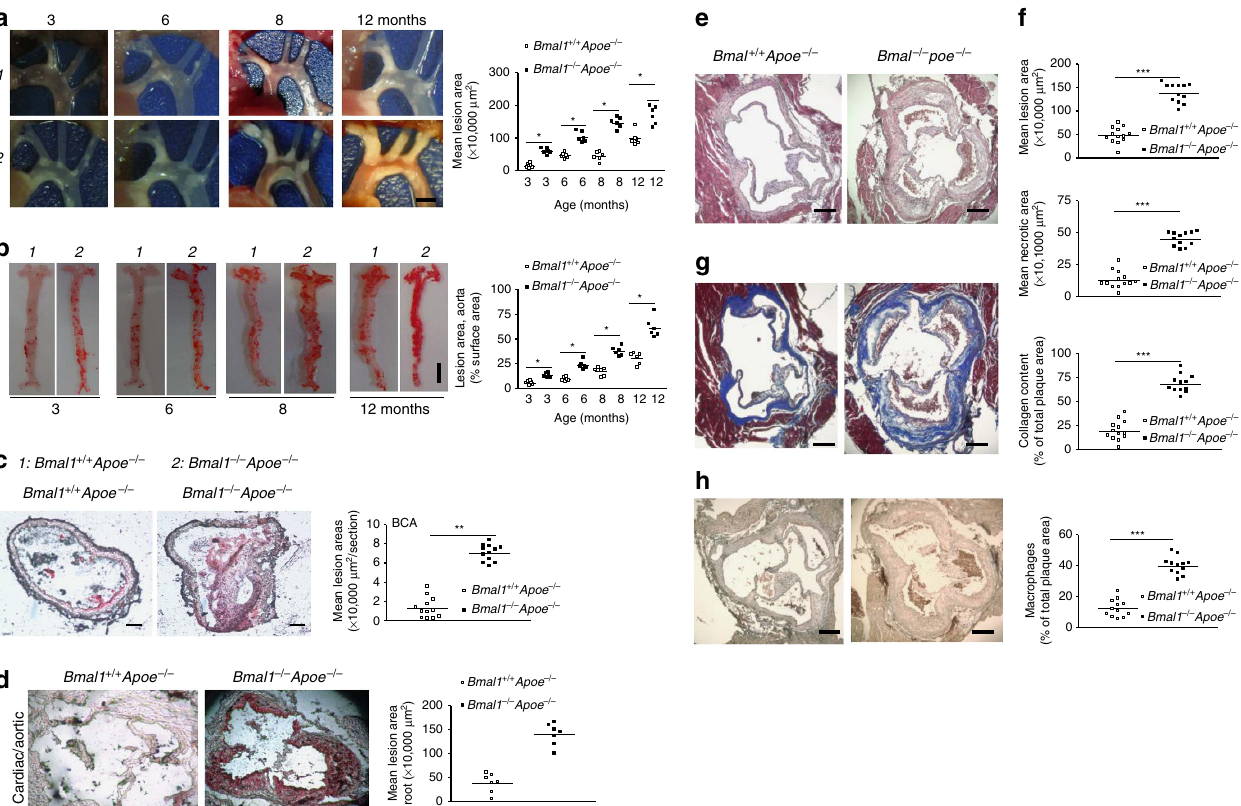
Figure 1 | Bmal1 deficiency enhances atherosclerosis in Apoe (cid:2) / (cid:2) mice. Bmal1 (cid:2) / (cid:2) Apoe (cid:2) / (cid:2) (black square) and Bmal1 þ / þ Apoe (cid:2) / (cid:2) (white square) male mice were fed a chow diet ( n ¼ 6 for each age group) for 3, 6, 8 or 12 months. ( a ) Aortic arches were dissected at indicated ages and photographed. A representative picture of atherosclerotic lesion for each age group is shown (left). Scale bar, 2mm. The plaque lesion areas were quantified in all animals and plotted (right). ( b ) Representative cardiac-aortic section stained with Oil Red O for each age is shown (left). Scale bar, 5mm. Lipid stained areas from all animals were quantified (right). ( c ) Bmal1 (cid:2) / (cid:2) Apoe (cid:2) / (cid:2) and Bmal1 þ / þ Apoe (cid:2) / (cid:2) male mice were fed a chow diet. Section from BCA (Scale bar, 40 m m) of 8-month-old male mice were stained with Oil Red O, and quantified. ( d – h ) Bmal1 (cid:2) / (cid:2) Apoe (cid:2) / (cid:2) and Bmal1 þ / þ Apoe (cid:2) / (cid:2) male mice were fed a chow diet. Section from cardiac/aortic junctions (Scale bar, 400 m m) of 8-month-old male mice were stained with Oil Red O, and quantified. Sections from cardiac–aortic junctions were stained with H & E and Oil Red O to quantify lipid lesions and necrotic areas ( e , f ), with Masson trichrome to measure collagen content ( g ) or with anti-macrophages (AIA31240) antibodies to detect macrophages ( h ). Data in a and b are mean ± s.d., n ¼ 6 per group, * P o 0.05, one-way ANOVA; data in c – h are mean ± s.d., n ¼ 10–12, ** P o 0.01, *** P o 0.001, one-way ANOVA. Error bars represent